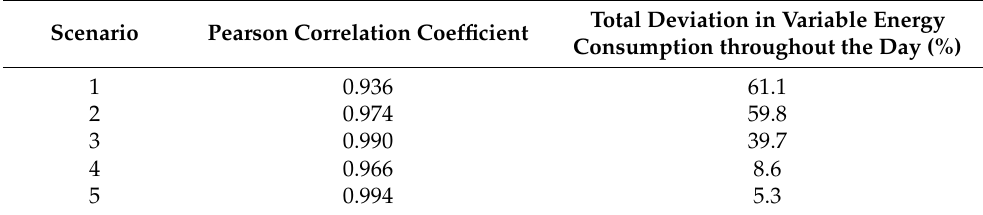
Table 11. Comparison of variable energy consumption prediction effects under different